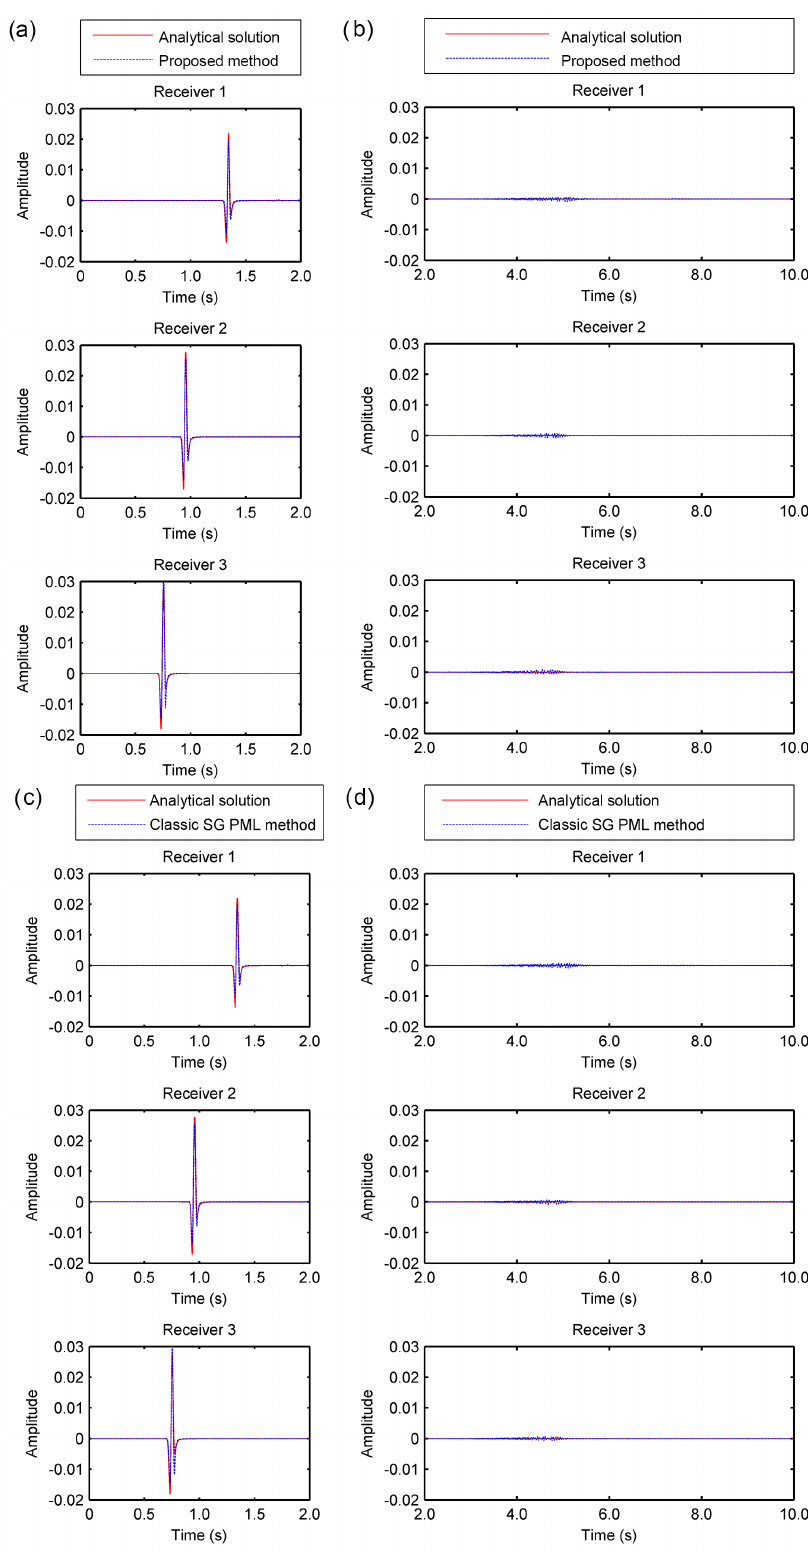
Figure 7. d = 10m; the rest is the same as in Fig. 6.